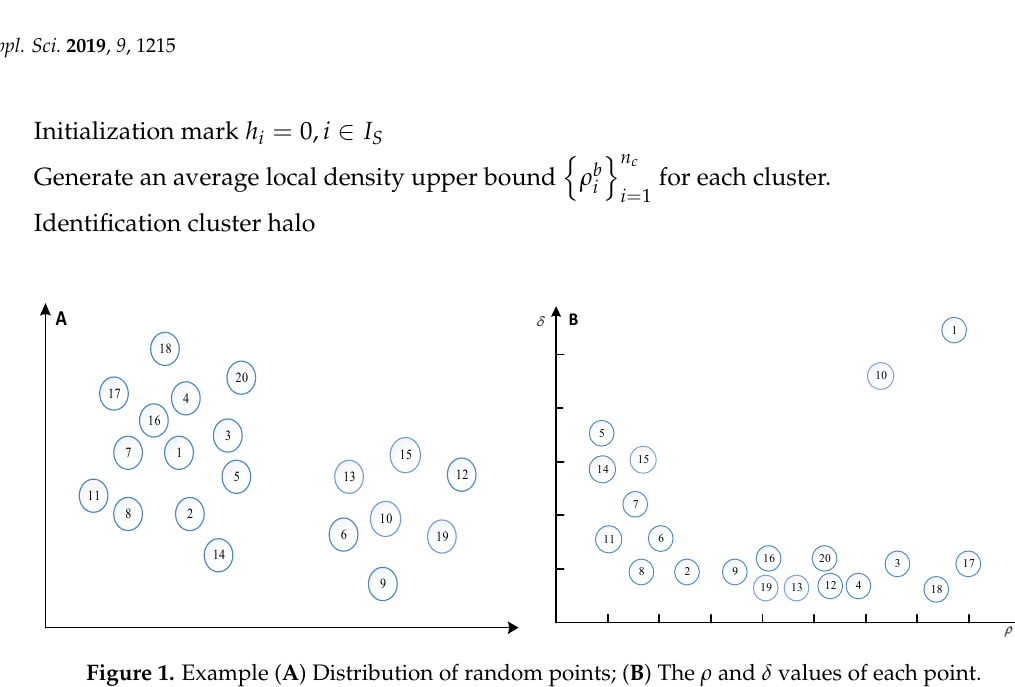
Figure 1. Example ( A ) Distribution of random points; ( B ) The ρ and δ values of each point.